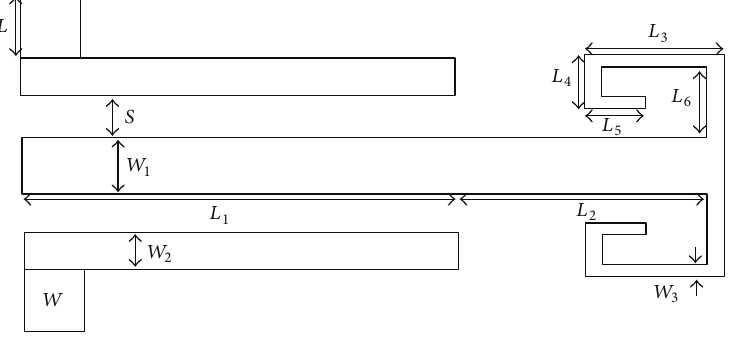
Figure 22: Structure of the proposed broadband band-pass filter.